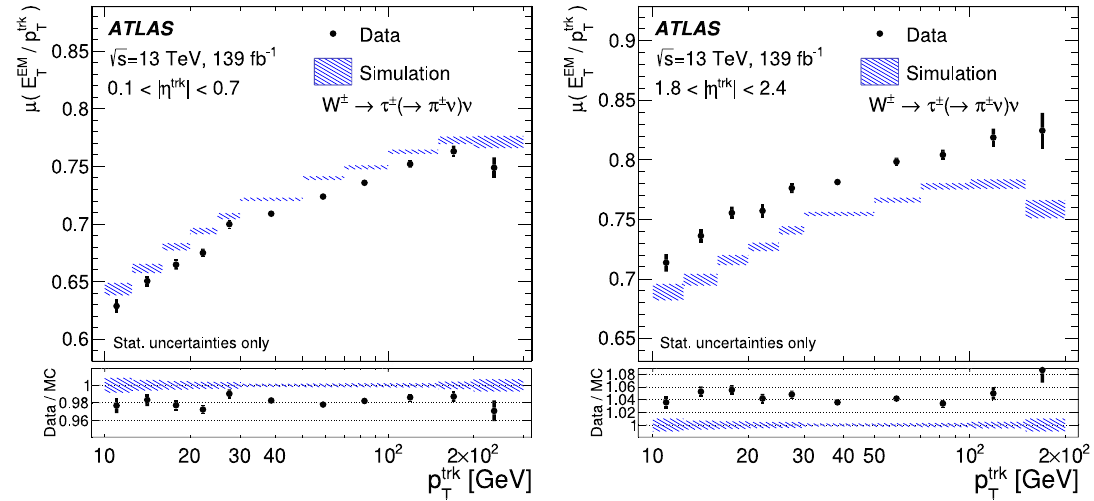
/ p trk Fig. 2 The fitted mean of the signal E EM distribution as a function of the track p T in the central region (left) and endcap region (right). The T T error bars and uncertainty band show only the statistical uncertainties from the size of the dataset and simulated samples